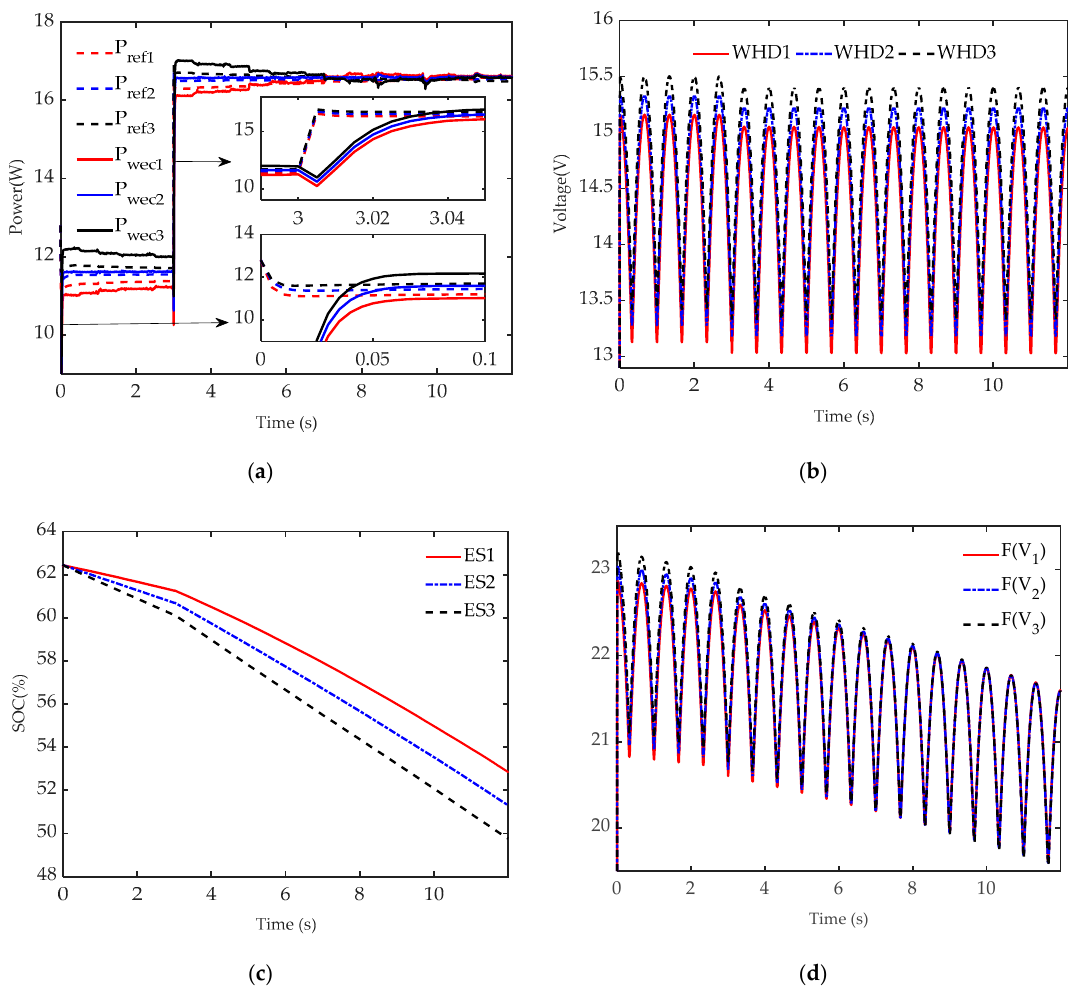
Figure 11. Performance of WECs with different initial WHD output: ( a ) Reference output power of each WEC; ( b ) Voltage of each WHD; ( c ) SOC curve; ( d ) WEC integral energy state F ( V i ) of each WEC.